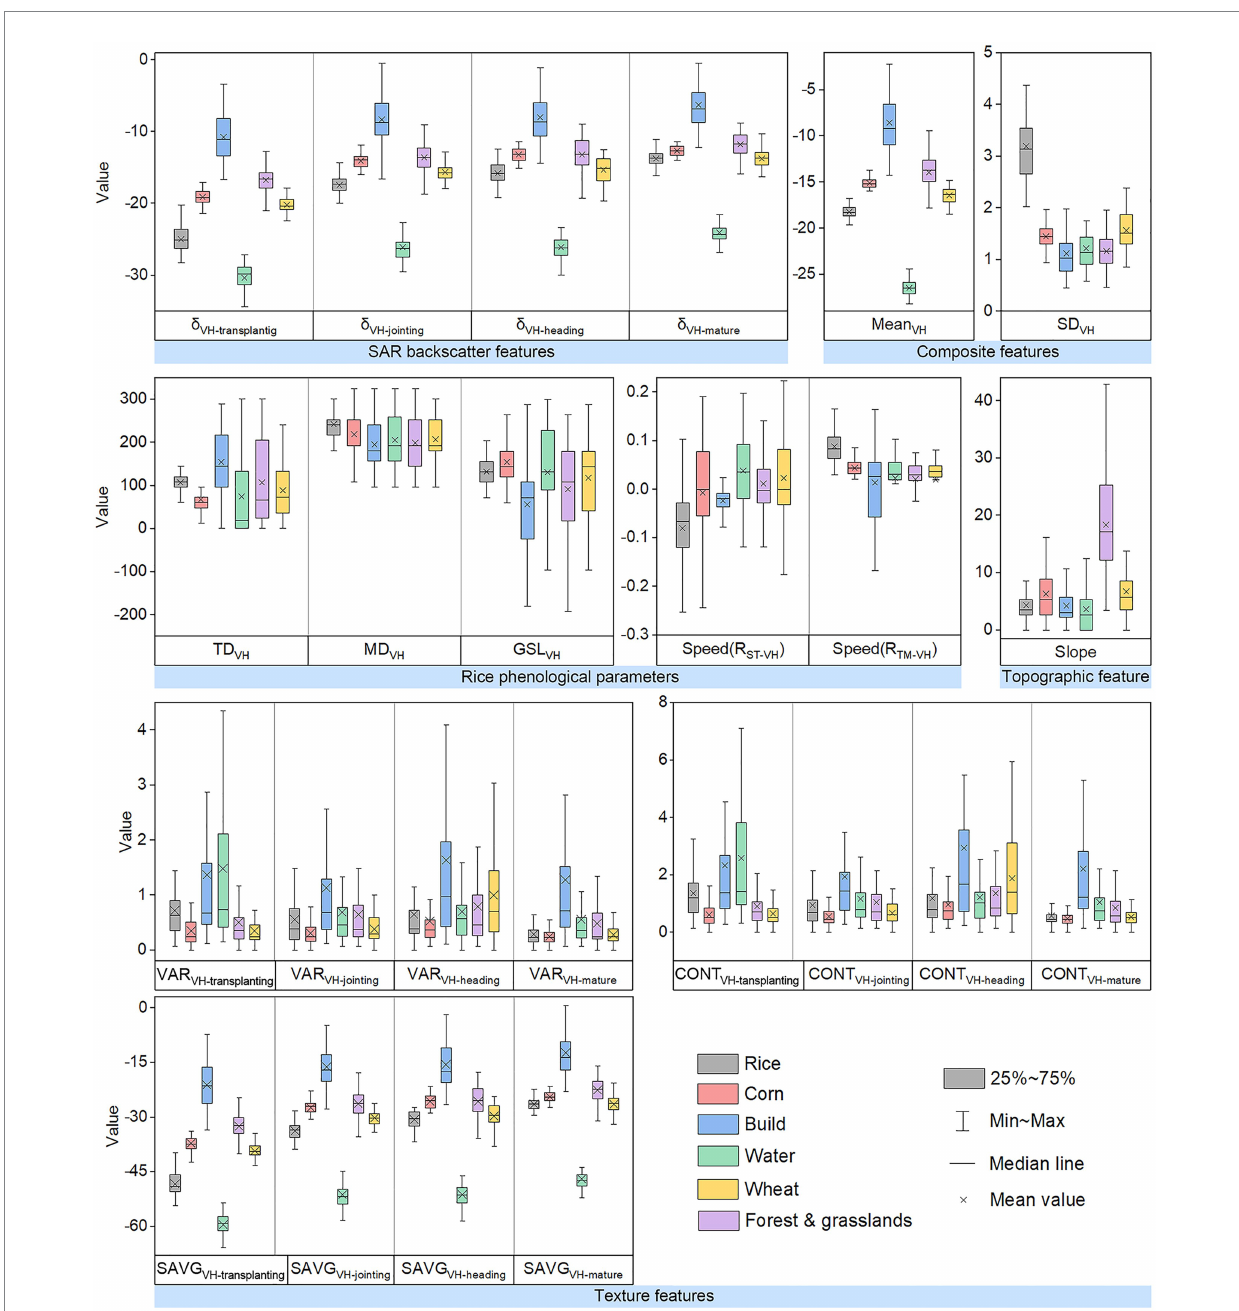
FIGURE 7 Separability of rice and other land cover types in each feature image based on VH Polarimetric Images. The δ VH-transplanting , δ VH-jointing , δ VH-heading , δ VH-mature represent SAR backscatter coefficients at four key phenological stages of rice (transplanting, jointing, heading and mature stages), Mean VH and SD VH represent the mean and standard deviation calculated based on all Sentinel-1 images throughout the rice growing season, SAVG VH-transplanting , SAVG VH- joining , SAVG VH-heading , SAVG VH-mature , VAR VH-transplanting , VAR VH-joining , VAR VH-heading , VAR VH-mature , CONT VH-transplanting , CONT VH-joining , CONT VH-heading and CONT VH-mature represent three types of texture parameters at four key phenological stages of rice, namely sum average, variance and contrast, slope represents topographic slope